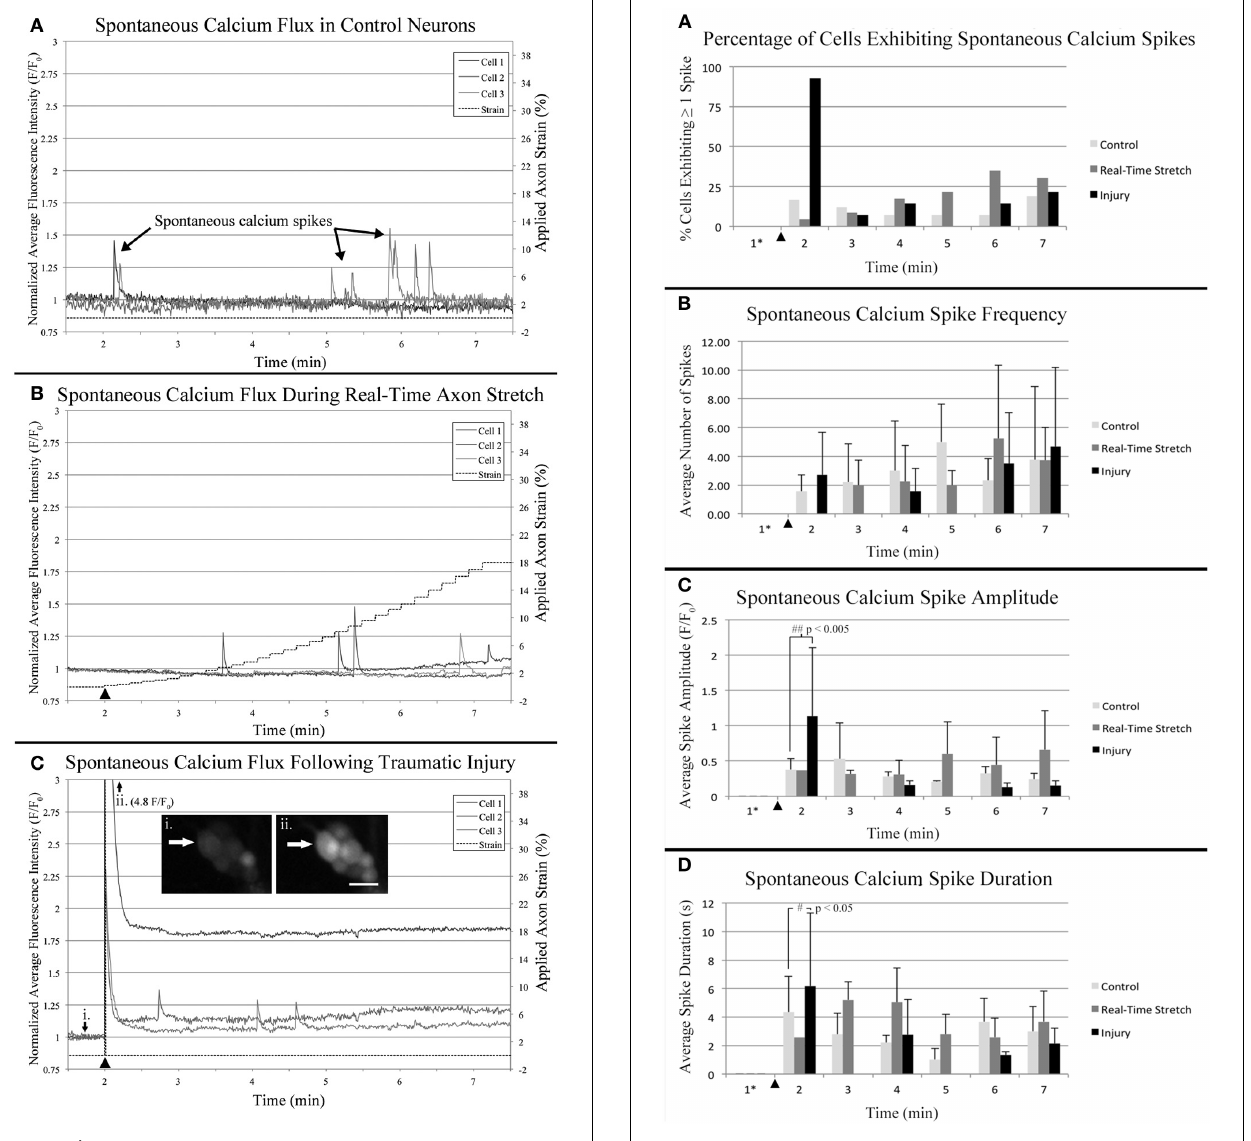
p = 0 . 002) and stretch-axotomy measured 112 ± 27 μ m 2 ( n = 51, p < 0 . 0001). Interestingly, moderate stretch-growth